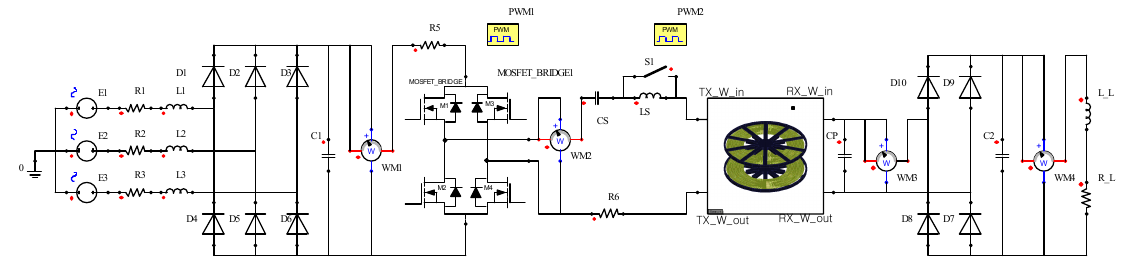
Figure 13. The joint simulation method of Simplorer and Maxwell.